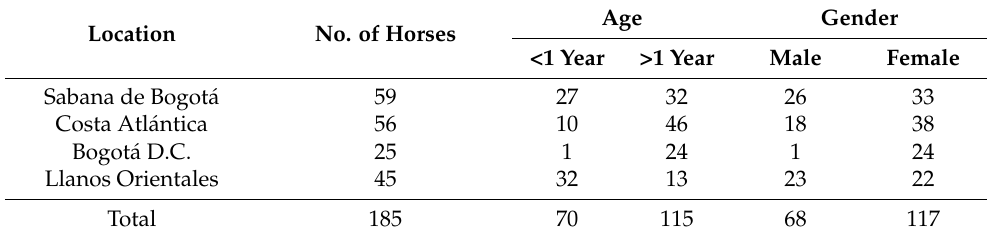
Table 1. Number of horses examined for Blastocystis by location with information on age and gender.